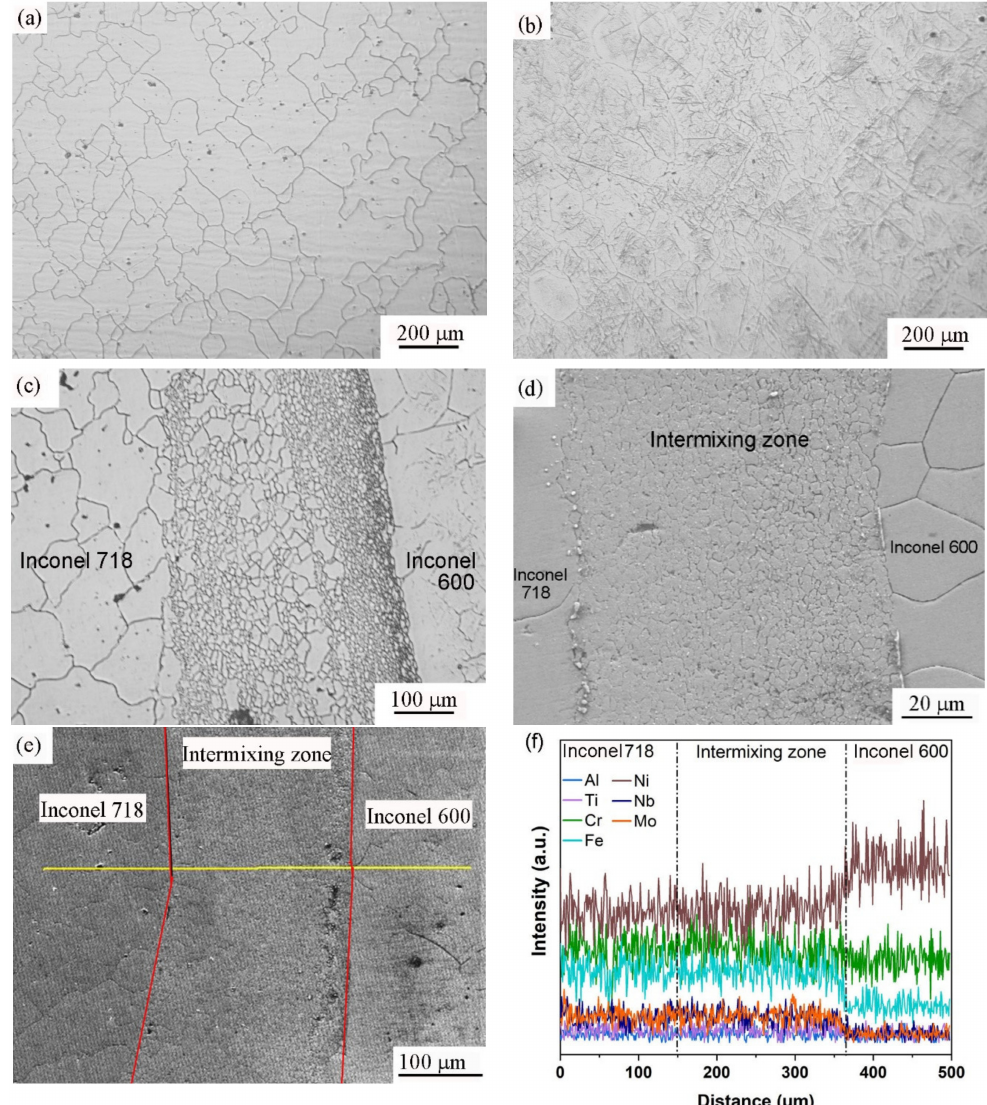
Figure 3. ( a , b ) heat effected zone (HAZ) micrographs of Inconel 718 and Inconel 600, respectively, showing grain coarsening. ( c , d ) optical and SEM micrographs of the weld interface, respectively. ( e , f ) results of the EDS line scan across the weld